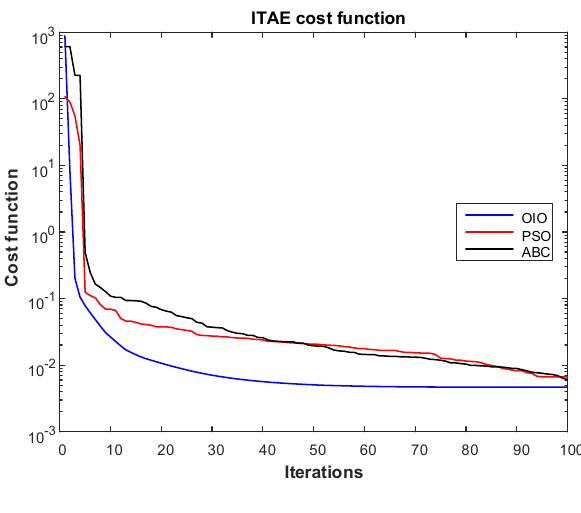
Figure 15. Iteration history for ITAE.